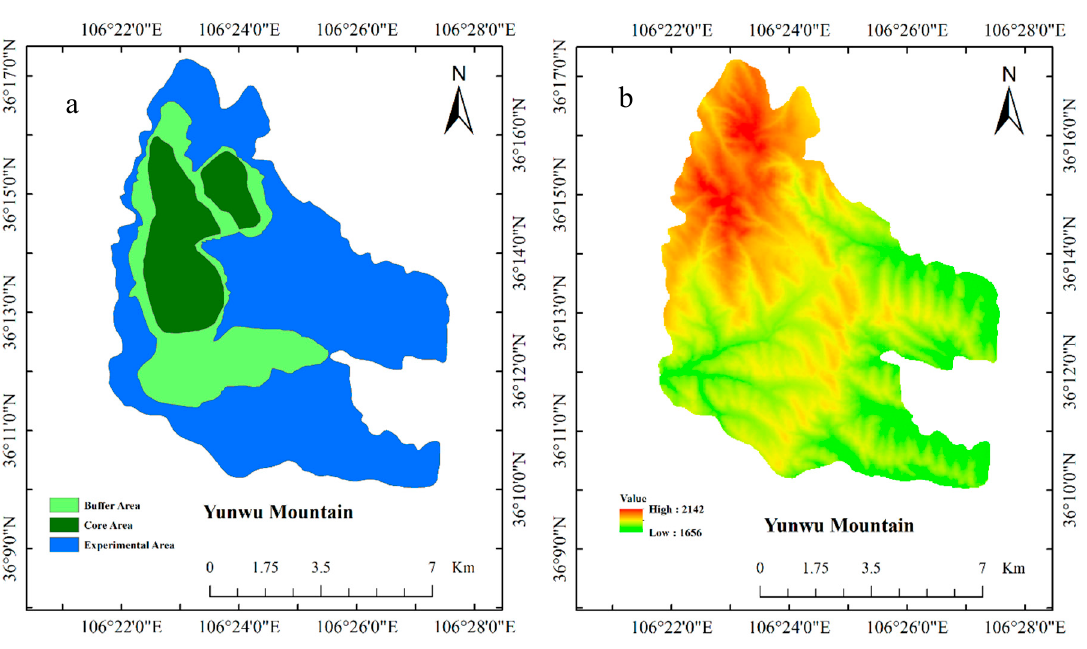
Figure 1. The studied area under different succession stages. ( a ) the setup of different functional areas; ( b ) the digital elevation model map. Table 1. Descriptions of the soil sample sites under different restoration ages.